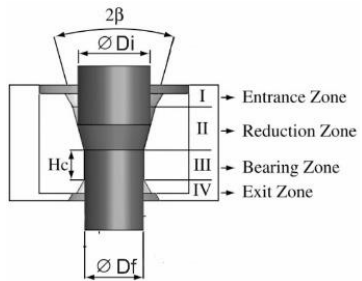
Figure 1. Schematic illustration of the internal longitudinal section structure of the wire die.